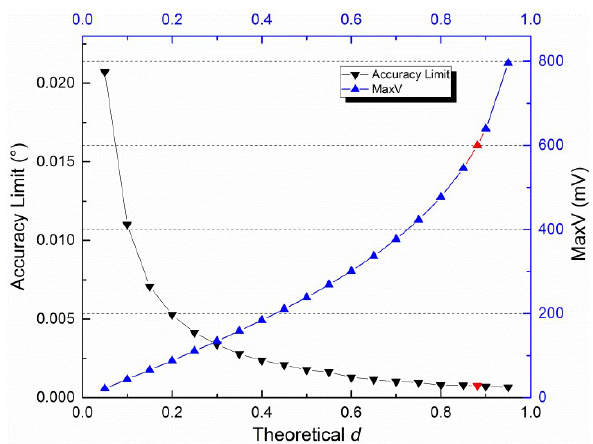
Figure 6. Maximum of V i_AD and accuracy limit for θ when d is between 0.05 and 0.95.